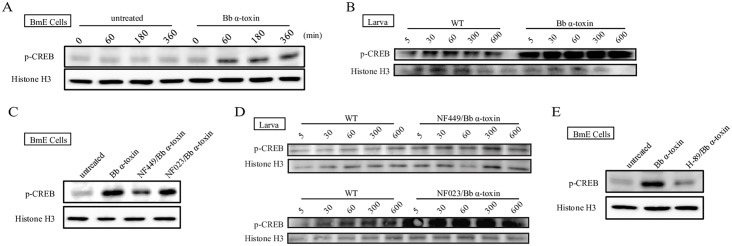
Effects of PKA substrate that mimics its phosphorylation by Bb α-toxin protein.(A) Western blot analysis of the expression level of phosphorylated CREB (p-CREB), showing an increase in CREB phosphorylation in after Bb α-toxin protein treatment in BmE cells but no such increase in the untreated cells. (B) Immunoblots showing the effect of p-CREB with Bb α-toxin protein treatment in vivo. (C) In vitro assay evaluating the regulatory effect of CREB phosphorylation in the presence of NF449 or NF023 at 1μM with Bb α-toxin protein treatment in BmE cells. (D) In vivo assessment of CREB phosphorylation in the presence of NF0449 or NF023 with Bb α-toxin protein on the larvae. (E) Effect of CREB phosphorylation in the presence of cell-permeable inhibitors of PKA (H-89: 20μM) with Bb α-toxin protein treatment. Total proteins were extracted and blotted with antibodies against p-CREB and Histone H3.